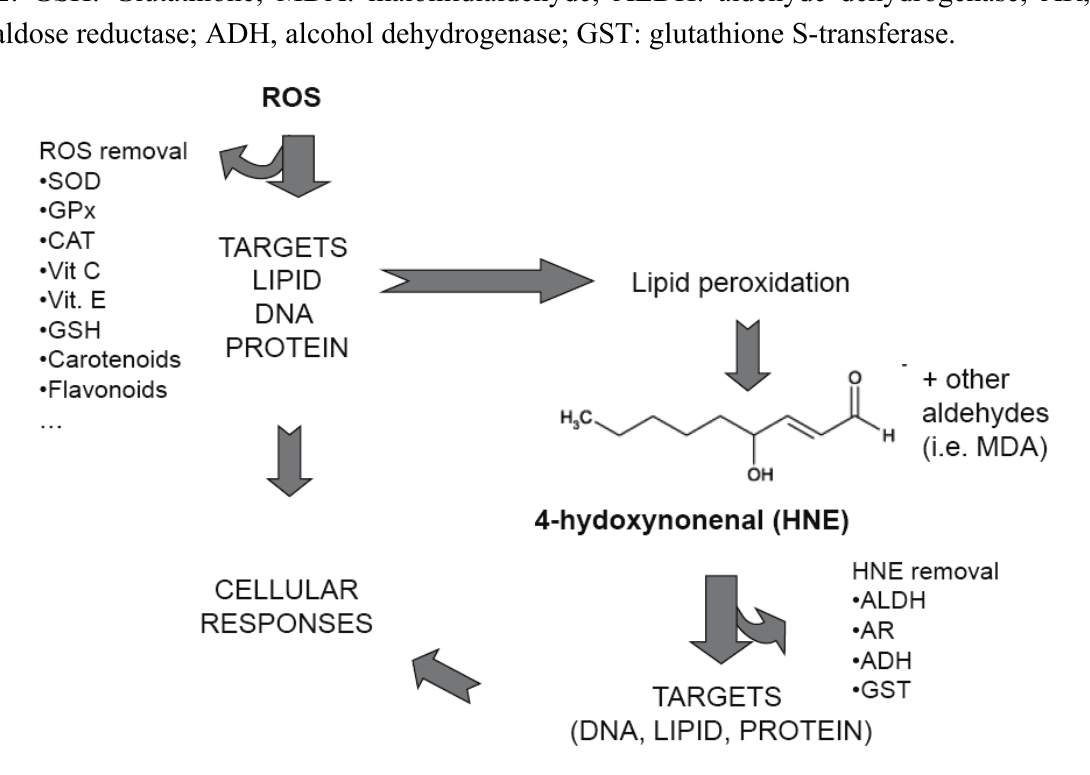
Scheme 1. Simplified scheme showing ROS and HNE pathways. SOD: